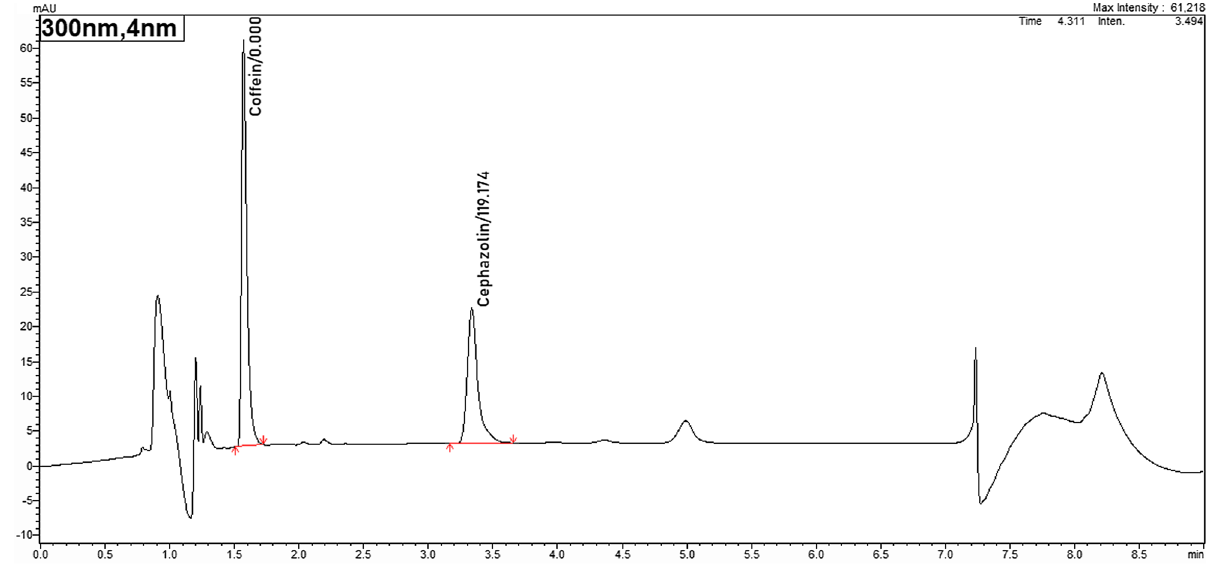
Figure 1. Chromatogram of total cefazolin concentration. This figure shows a typical HPLC (High Performance Liquid Chromatograph) chromatogram of cefazolin and the internal standard (caffein). The x-axis shows the run time in minutes while the y-axis demonstrates the absorption of the tested substance at 300 nm wavelength in absorbance units (AU). With a flow rate of 0.35 ml/min, cefazolin shows a retention time of 3.16 min in this